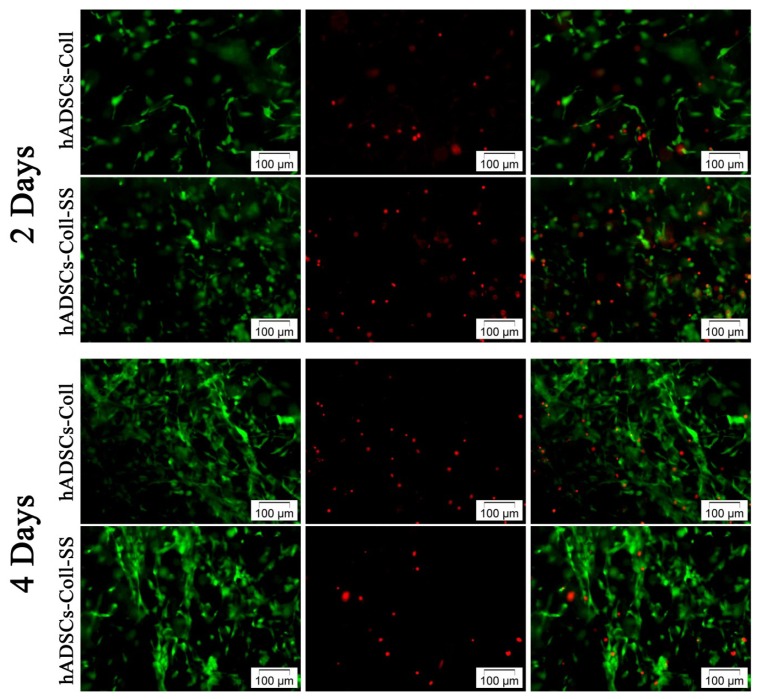
Fluorescence microscopy detection of live (green-labeled) and dead (red-labeled) human adipose-derived stem cells (hADSCs) in contact with Coll and Coll-SS biomatrices at 2, 4 and 6 days post seeding.